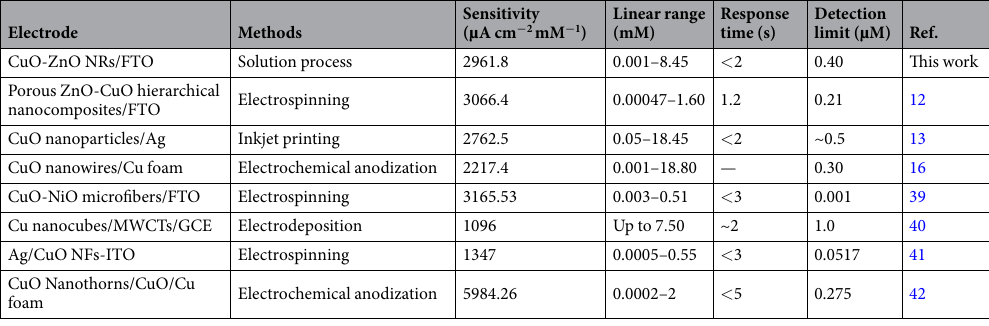
Table 1. Comparison of the non-enzymatic electrochemical sensors based on direct modification of sensing